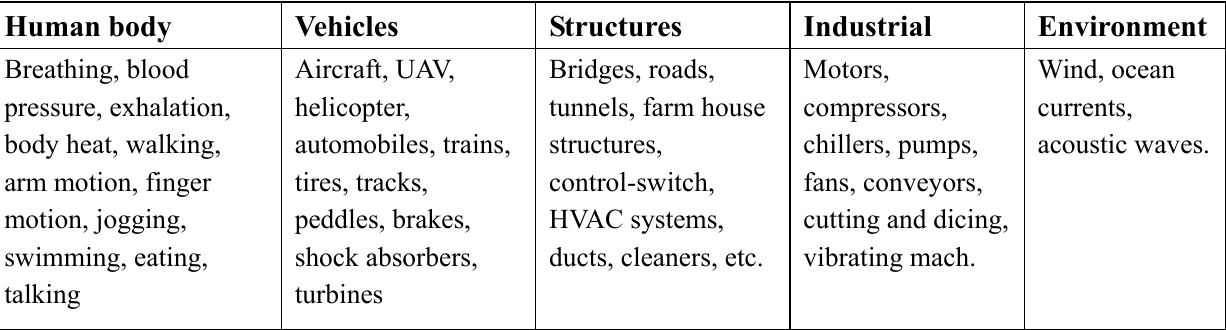
Table 1 . Sources of energy available in the surrounding which are/can be tapped for generating electricity [identified in first draft of standards on vibration energy harvesting, Center for Energy Harvesting Materials and Systems